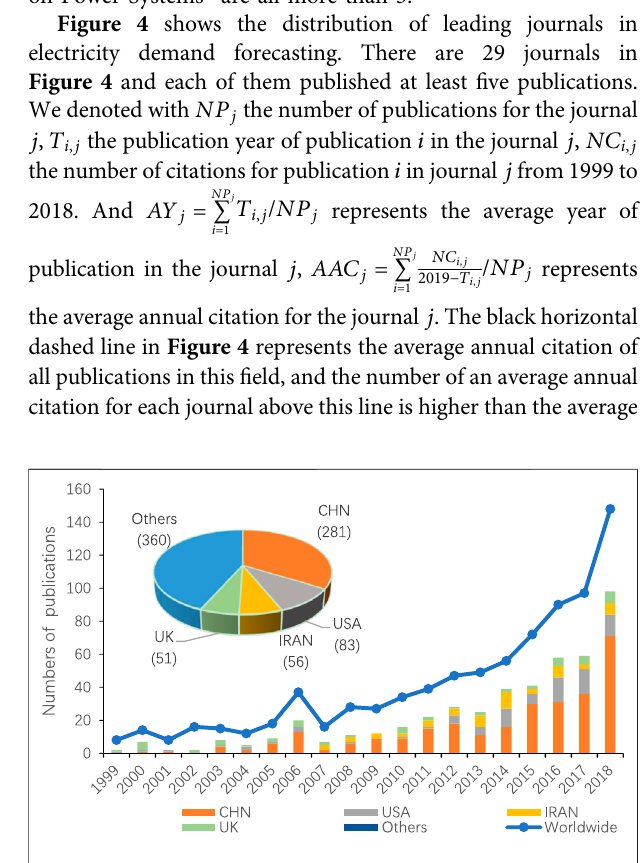
FIGURE2| Distributionofpublicationsinelectricitydemandforecasting, 1999 –